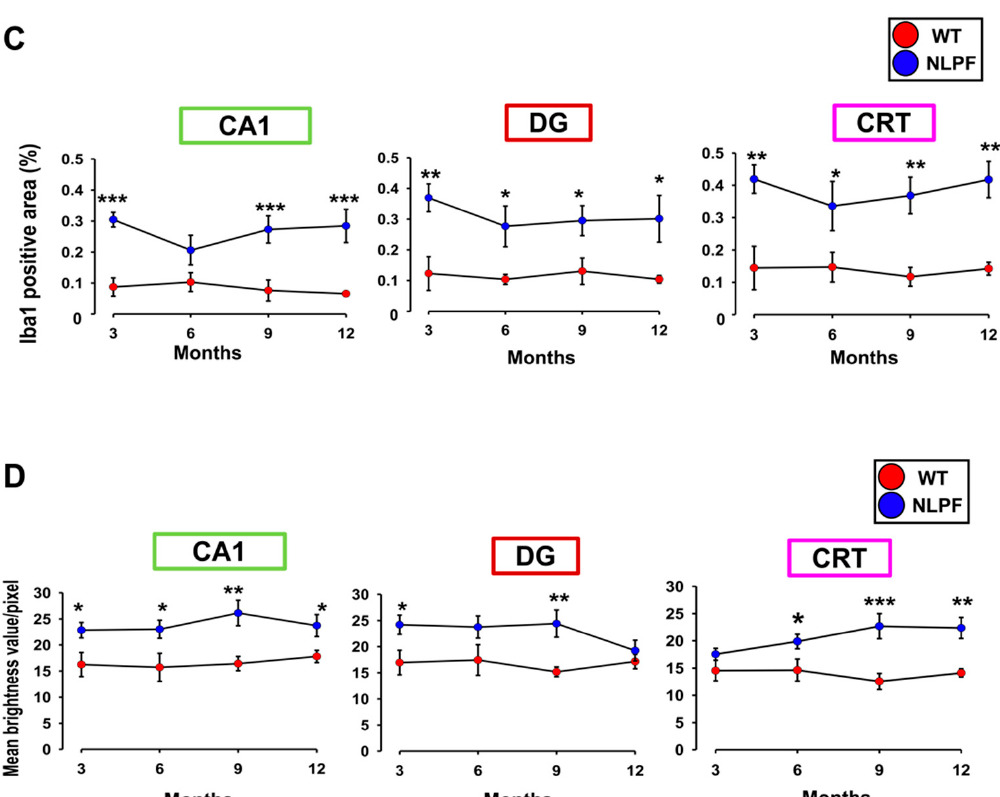
Figure 5. Neuroinflammation in the brain of APP NL-P-F/NL-P-F mice. ( A ) Iba1 and GFAP detected the glial cell activation in the hippocampal CA1, DG, and the cortex of APP NL-P-F/NL-P-F mice from three to twelve months of age. The scale bar indicates 50 µ m. ( B ) Representative images of gliosis in the cortex of APP NL-P-F/NL-P-F mice at twelve months of age. The scale bar indicates 50 µ m. ( C ) Iba1 fluorescence area (% of total area) and ( D ) GFAP fluorescence intensity (per pixel) in the hippocampal CA1, DG, and the cortex of APP NL-P-F/NL-P-F mice from three to twelve months of age. WT ( n = 5–6), NLPF ( n = 7–9). Values indicate the mean ± SEM. * p < 0.05, ** p < 0.01, *** p < 0.001, compared with age-matched WT.